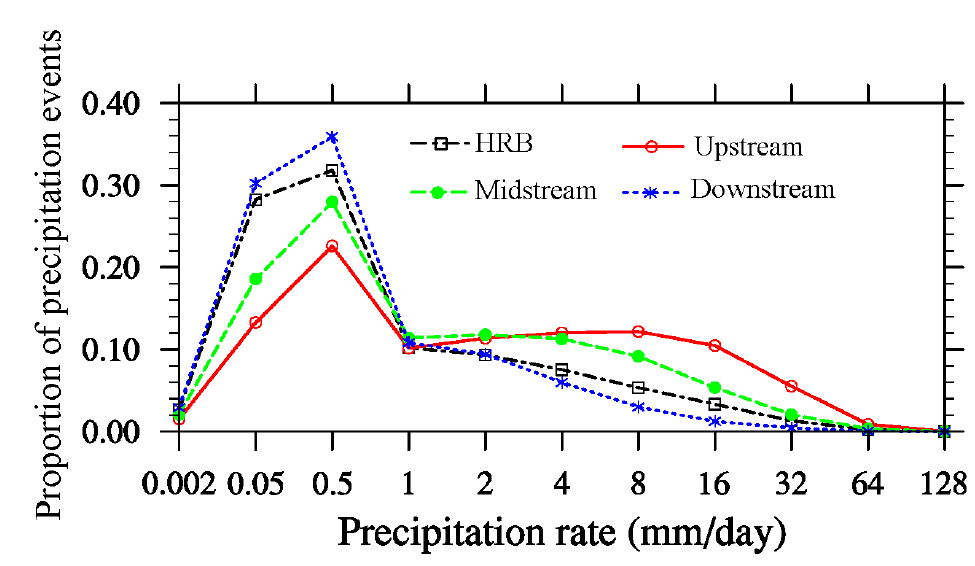
Figure 12. The proportion of all precipitation events with a particular daily precipitation rate in the HRB, and the upstream, midstream and downstream areas from 2000 to 2013.